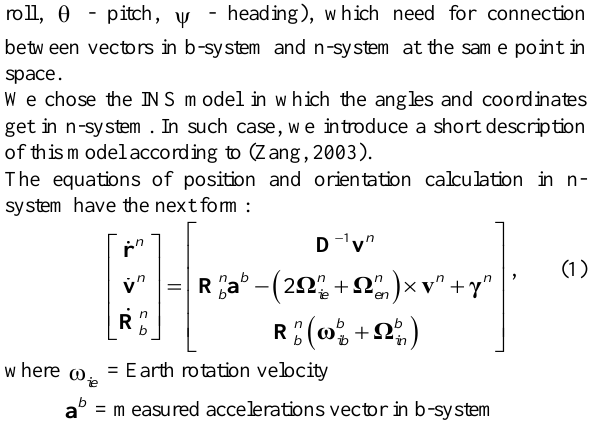
Figure 1. INS mechanisation (Zang,